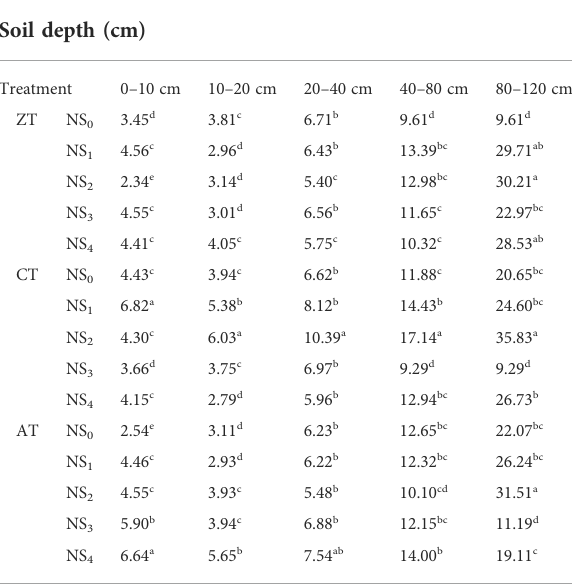
TABLE 6 Combined effects of tillage practices and N sources on nitrate nitrogen (NO 3 -N) accumulation (kg · ha − 1 ) in different soil depths at the end of the